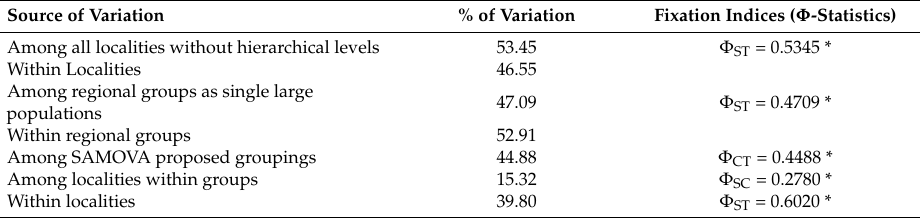
Table 2. Hierarchical analysis of molecular variance (AMOVA) for H. hydnorae across 18 localities. Tests were performed for regional groups as determined by the SAMOVA analysis (northern; central and southern), and for all localities without hierarchical levels. Asterisks (*) denote significance level ( p ≤